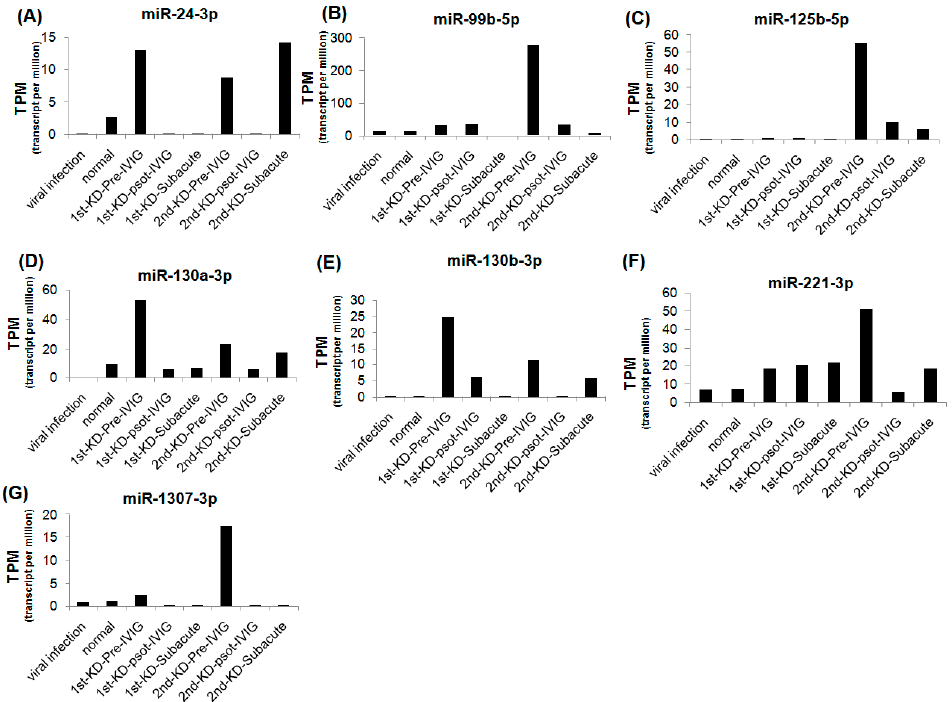
Figure 3. Expression levels of seven upregulated miRNA candidates in recurrent KD at different stages. The expression levels of miR-24-3p ( A ), miR-99b-5p ( B ), miR-125b-5p ( C ), miR-130a-3p ( D ), miR-130b-3p ( E ), miR-221-3p ( F ), and miR-1307-3p ( G ) were analyzed using NGS; miRNA expression levels are presented as TPM.